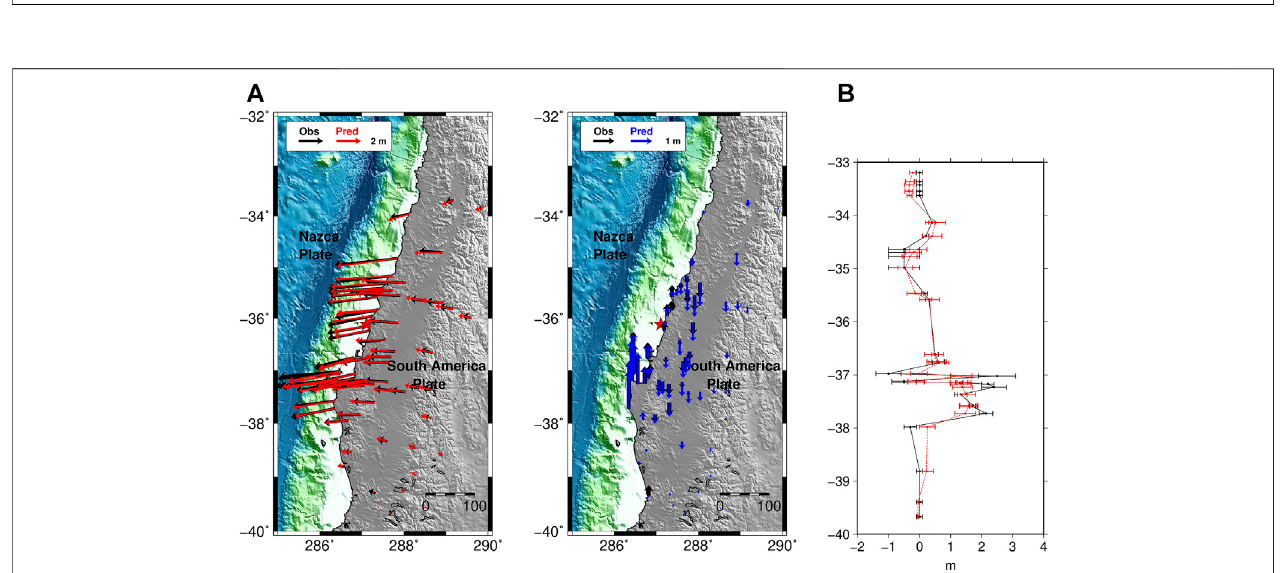
FIGURE 14 | GPS and land-level data fi t for the slip model shown in Figure 11 . Comparison between observed (in black) and predicted (A) GPS data (horizontal andverticalinredandblue,respectively); (B) observed(black)andpredicted(red)land-levelchanges;errorbarsforobservationsareexperimentaluncertainties,whereas for predictions they are calculated adding ± 1 σ errors.